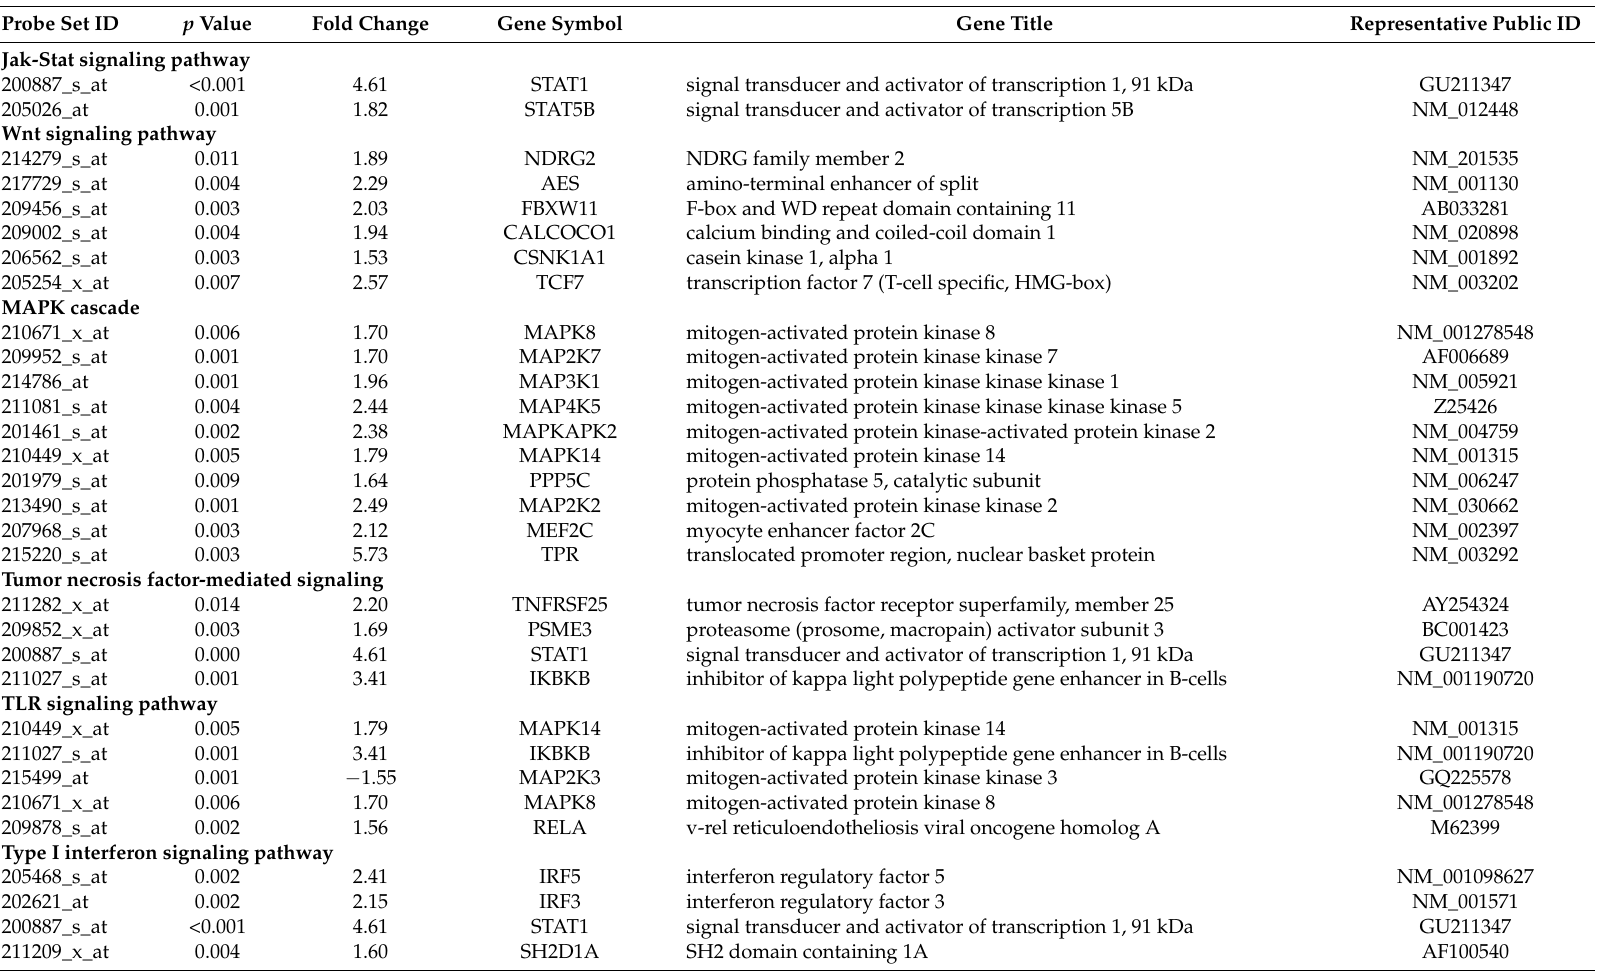
Table 2. Genes modulated in AS patients before treatment versus healthy controls grouped in signaling